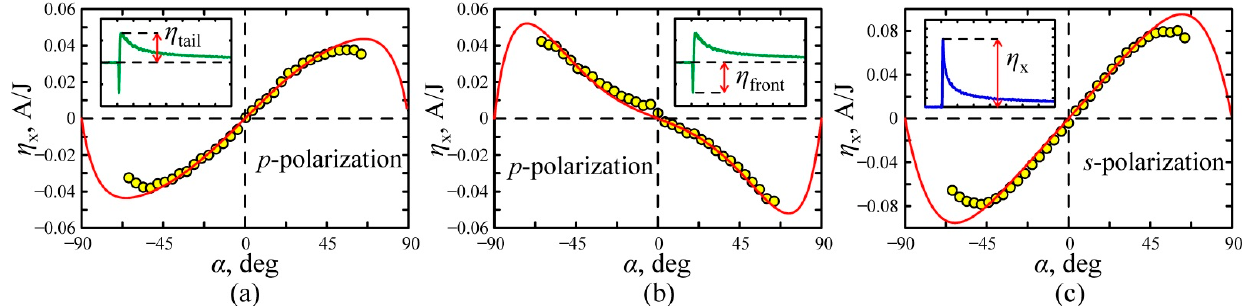
Figure 5. The dependence of the longitudinal light-to-current conversion efficiency on the incidence angle α for amplitude of the ( a ) tail part and ( b ) front part of the photocurrent pulses at the p -polarized excitation beam, ( c ) photocurrent pulse at the s -polarized excitation beam. The solid lines are approximations with parameters in Table 1. Insets to ( a – c ) show temporal profiles of the photocurrent pulse. Table 1. The fitting parameters for the experimental data.